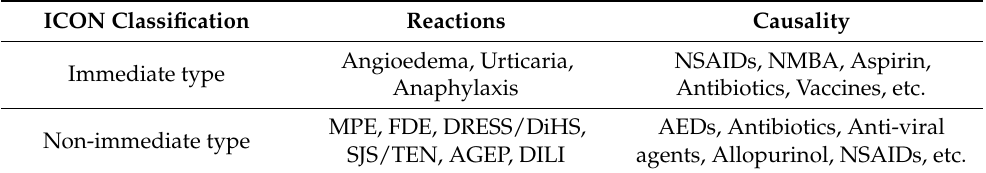
Table 1. Classification and clinical symptoms of drug hypersensitivity reactions based on the defini- tion by ICON. ICON Classification Reactions Causality Angioedema, Urticaria, NSAIDs, NMBA, Aspirin, Immediate type Anaphylaxis Antibiotics, Vaccines, etc. MPE, FDE, DRESS/DiHS, AEDs, Antibiotics, Anti-viral Non-immediate type SJS/TEN, AGEP, DILI agents, Allopurinol, NSAIDs,